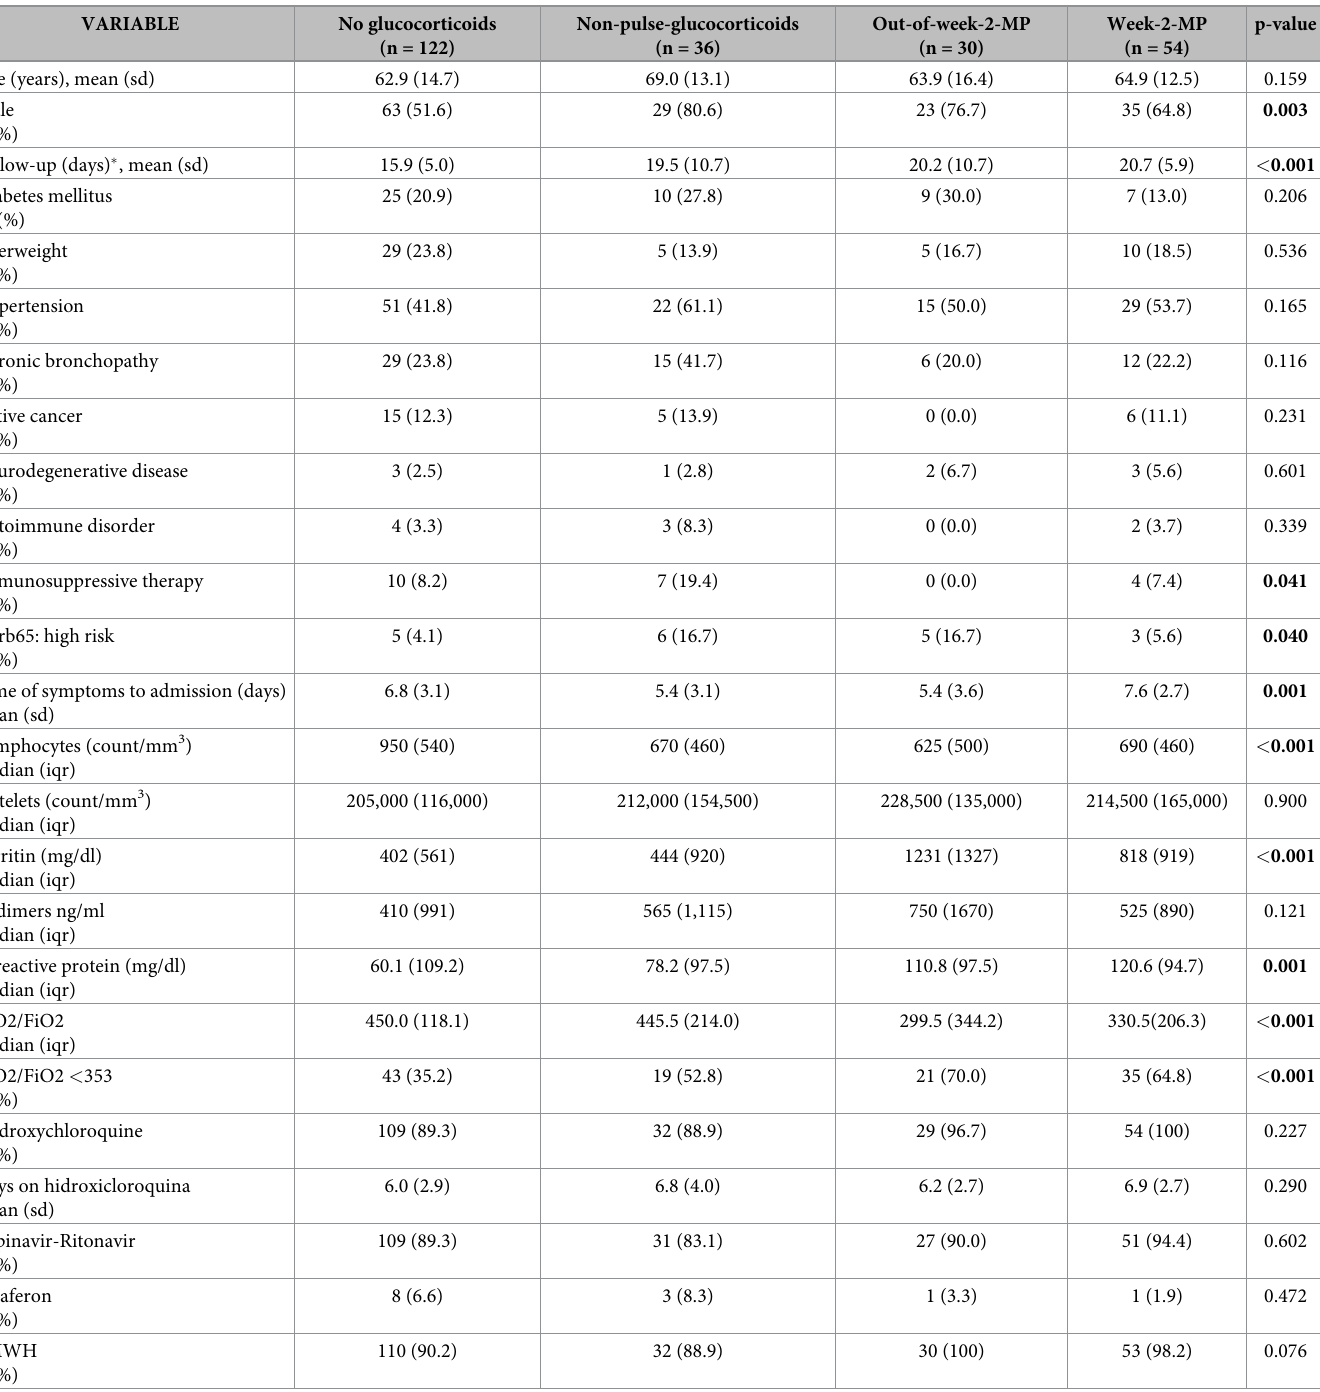
Table 4. Clinical characteristics of the cohort according to type of glucocorticoid